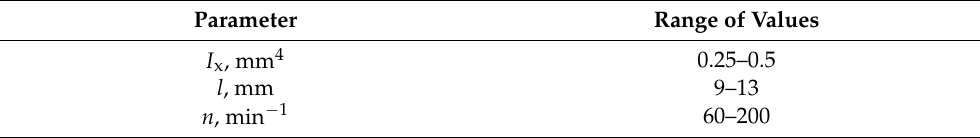
Table 1. Considered ranges of values of the studied design parameters [34].